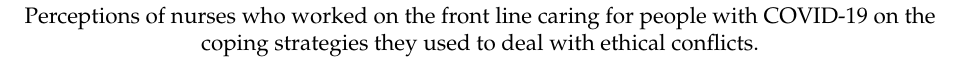
Table 2. Interview topic script. Perceptions of nurses’ perceived ethical conflicts during pandemic care: major ethical dilemmas and